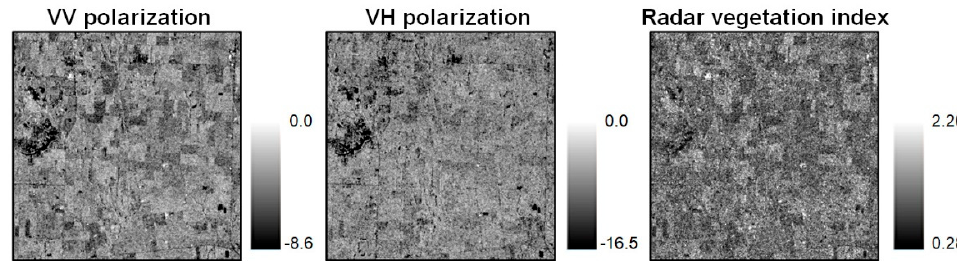
Figure 8. Sentinel-1 SAR dual-polarization images and radar vegetation index on 29 July 2019.